Question: Express in one sentence what the figure is showing.
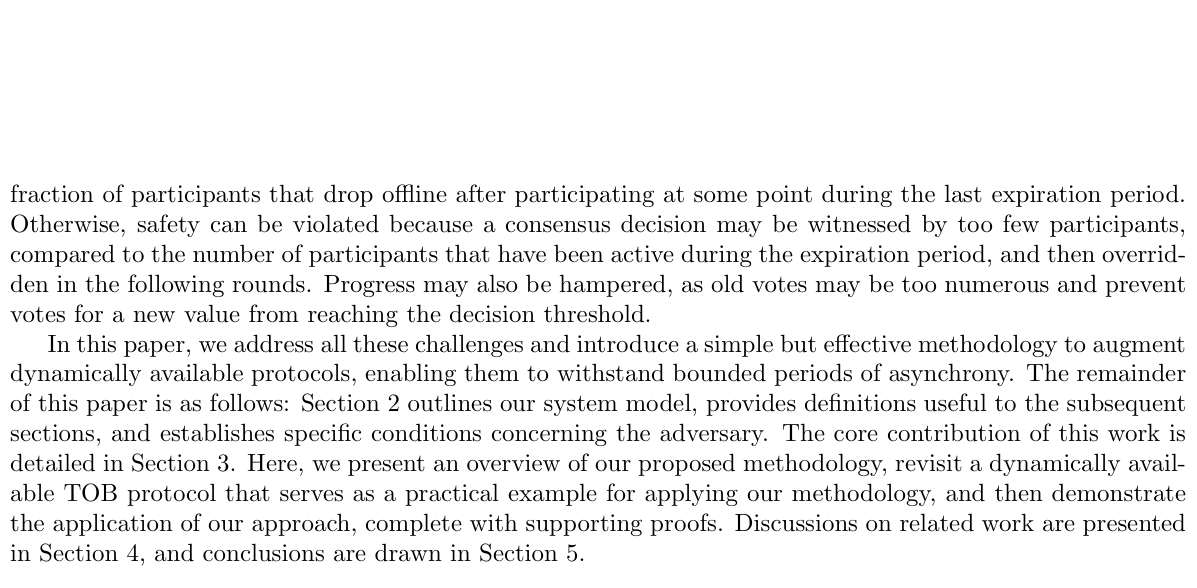
Answer: Allowable failure ratio ˜β2/3 to ensure progress during synchrony with an expiration period of η rounds and a churn rate of γ per η rounds. We assume an algorithm using a decision threshold of 1 −β = 2